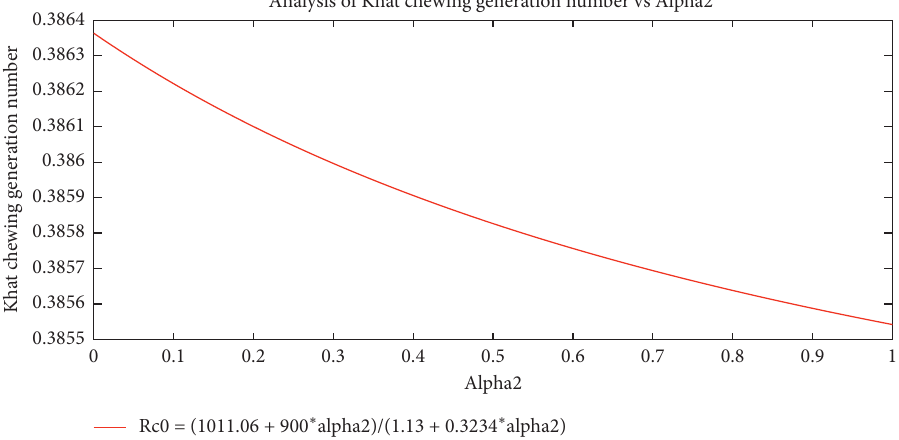
Figure 4: Khat-chewing generation number decreases as the value of α